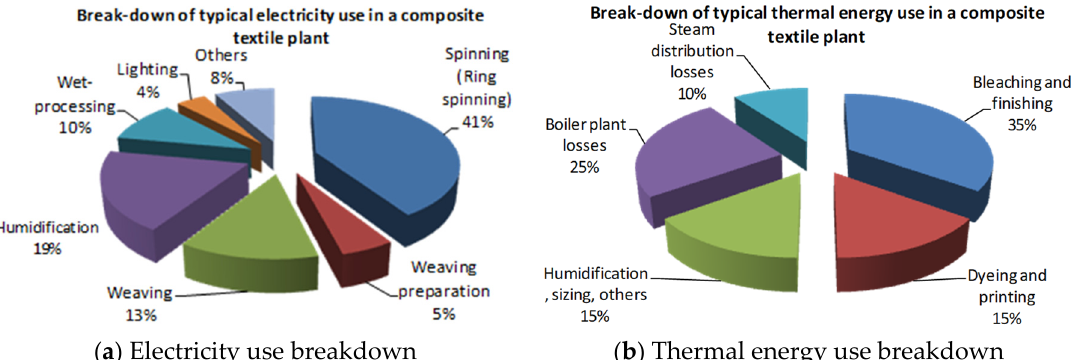
Figure 3. Breakdown of typical electricity and thermal energy used in a composite textile plant [17].